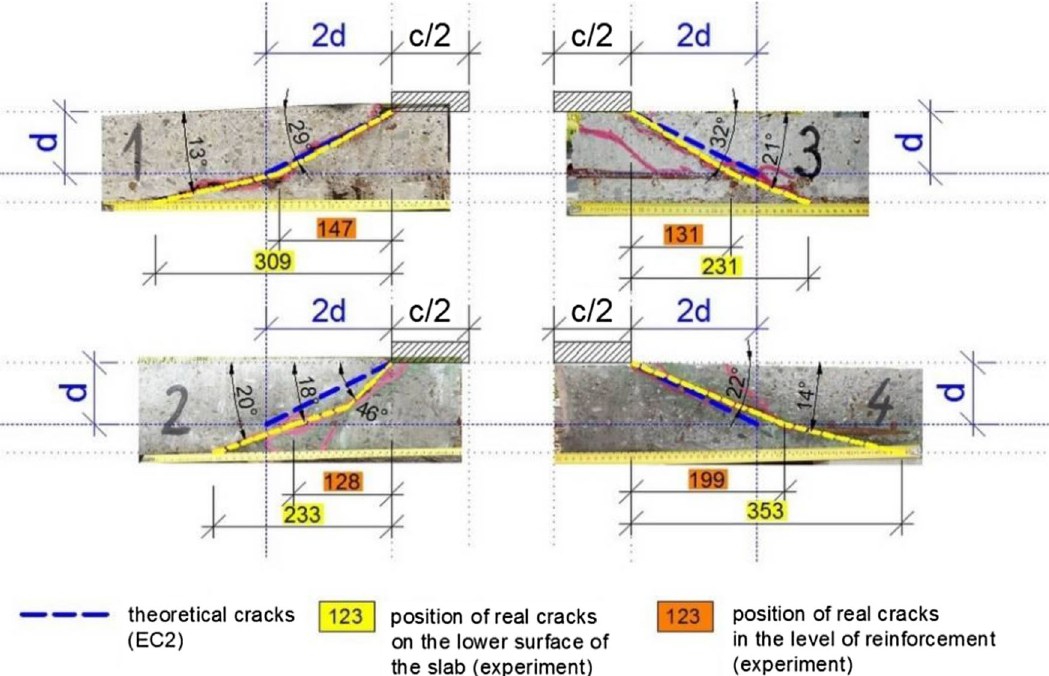
Fig. 8 Comparison of the measured values and the results of the design methods used in EC2 in lateral cuts of the slab